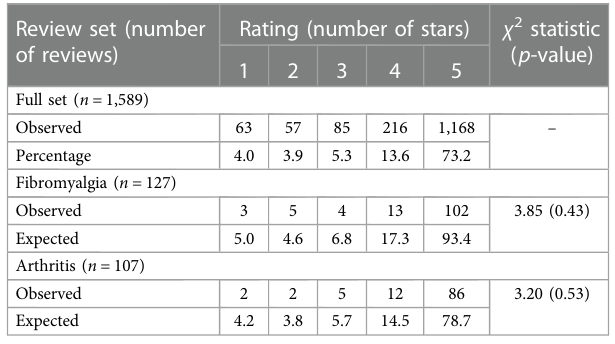
Table 1 as the most frequently occurring concept with CP in PubMed, but it does not appear to stand out as the largest hub in Figure 5 . Likewise, arthritis, as the second largest hub, does not have a direct presence in Table 1 , but it is unclear how many of those occurrences refer to osteoarthritis (ranked 4th in Table 1 ). That said, there is no reason to believe that consumer activities must align perfectly with the dominant interest of the research community, and any such discrepancies could also lead